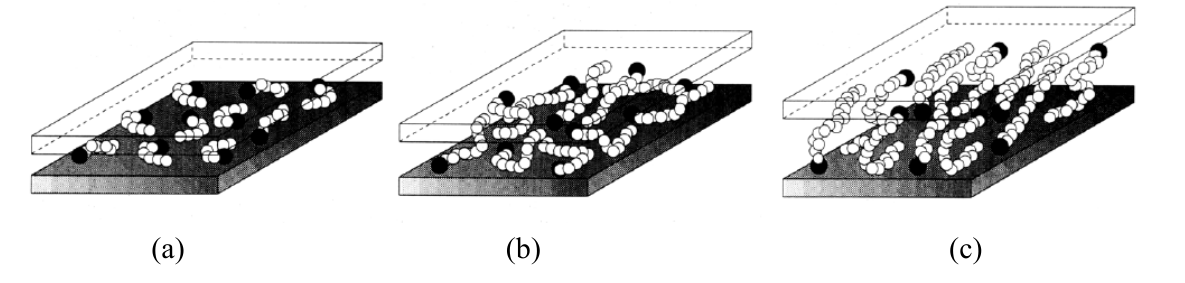
Figure 3. Alkyl chain aggregation models: For the shortest lengths (a), the molecules are effectively isolated from each other. At intermediate lengths (b), quasidiscrete layers form with various degrees of in plane disorder and interdigitation between the layers. For longer lengths (c), interlayer order increases. Reproduced from reference [41] with permission from The American Chemical Society.